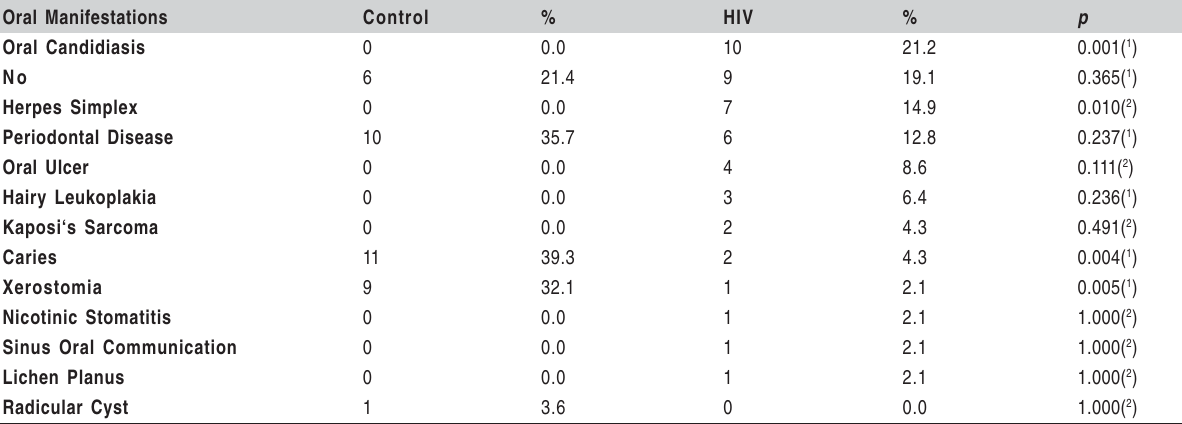
(1) descriptive level of probability of the chi-square test. (2) descriptive level of probability of Fisher’s exact